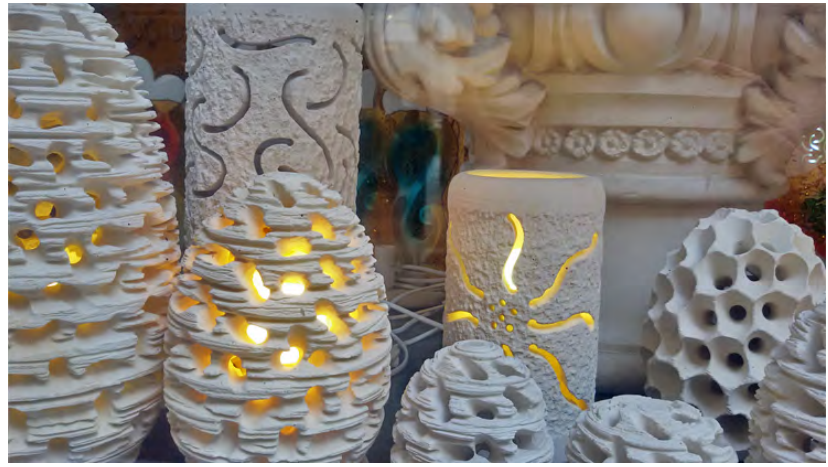
Figure 6. 3D printed ceramic